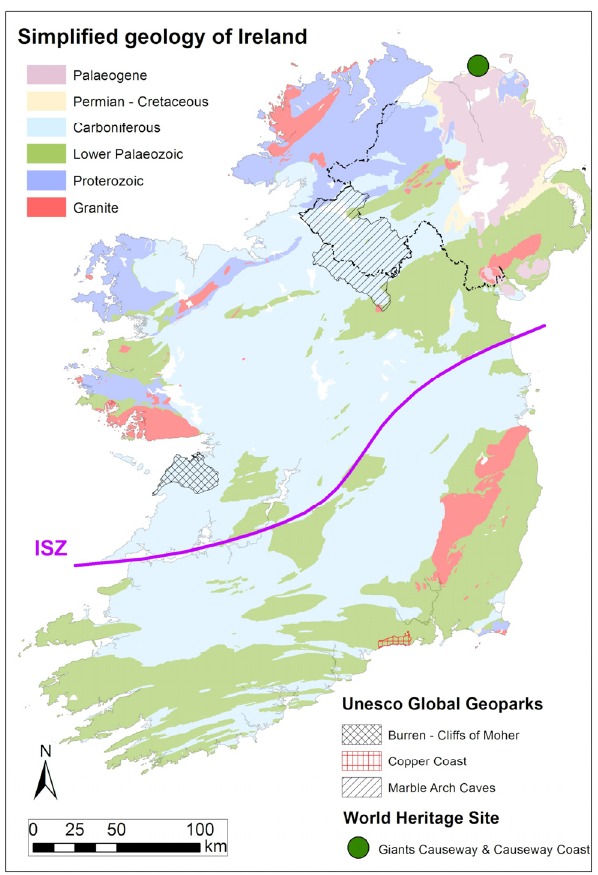
Figure 2. Simplified geology, UNESCO Global Geoparks and World Heritage Site (WHS) in Ireland [ISZ = Iapetus Suture Zone].